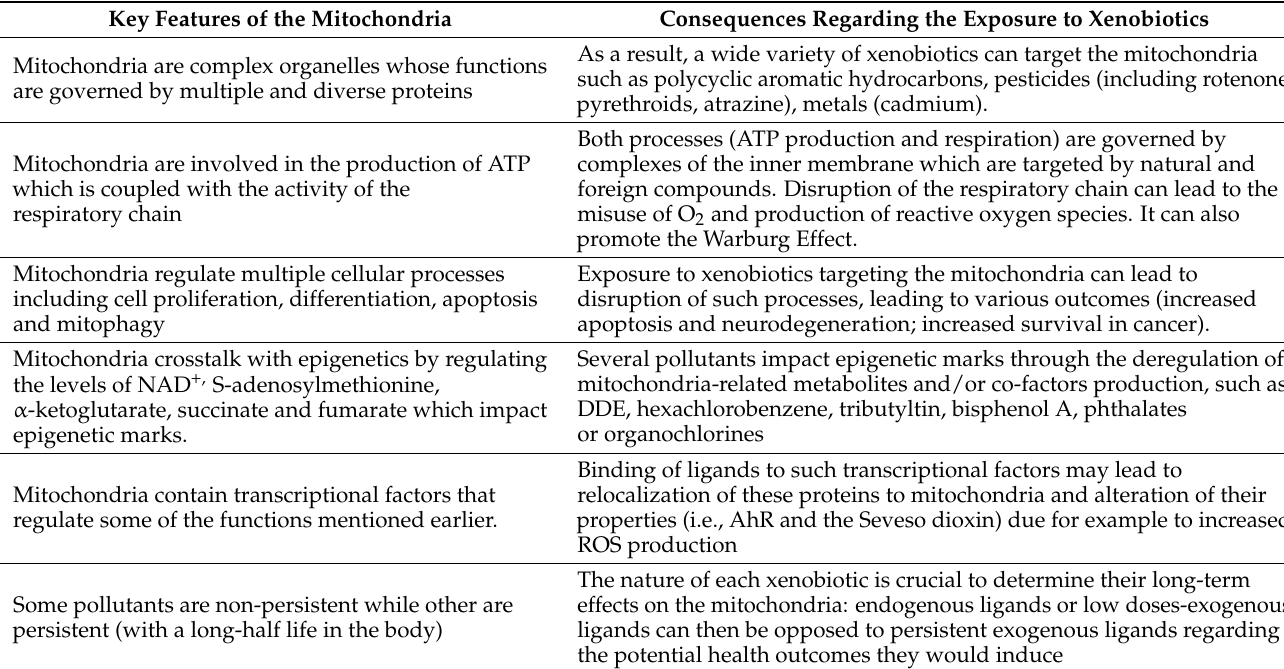
Table 1. Table summarizing the key features of the mitochondria (1st column) and the potential consequences of exposure to xenobiotics (2nd